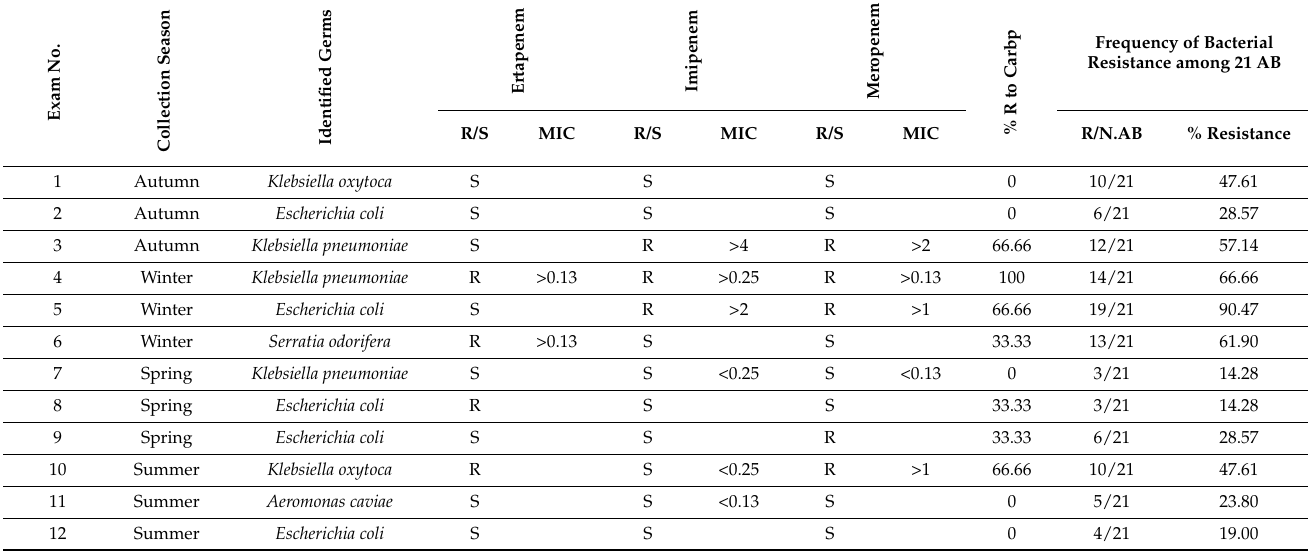
Table 3. The strains isolated and identified in Mother and Child Hospital effluents with their antibiotic